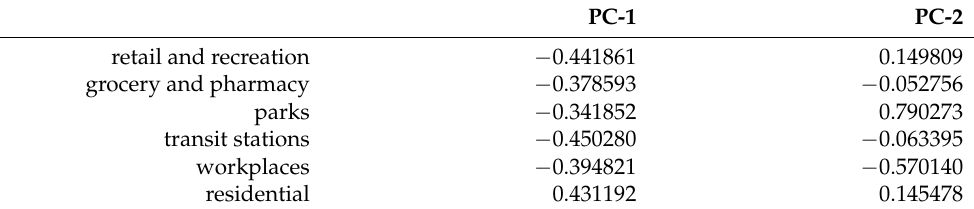
Table 4. Influence of mobility reporting data on PC projection variability.